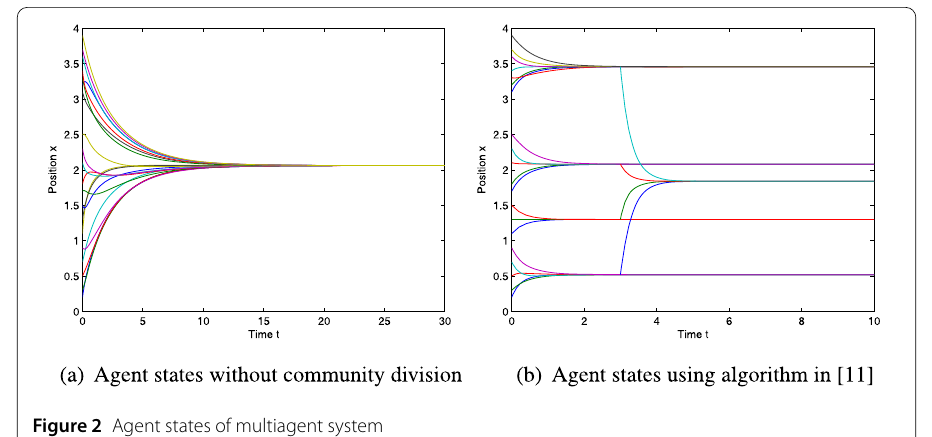
Figure 2 Agent states of multiagent system